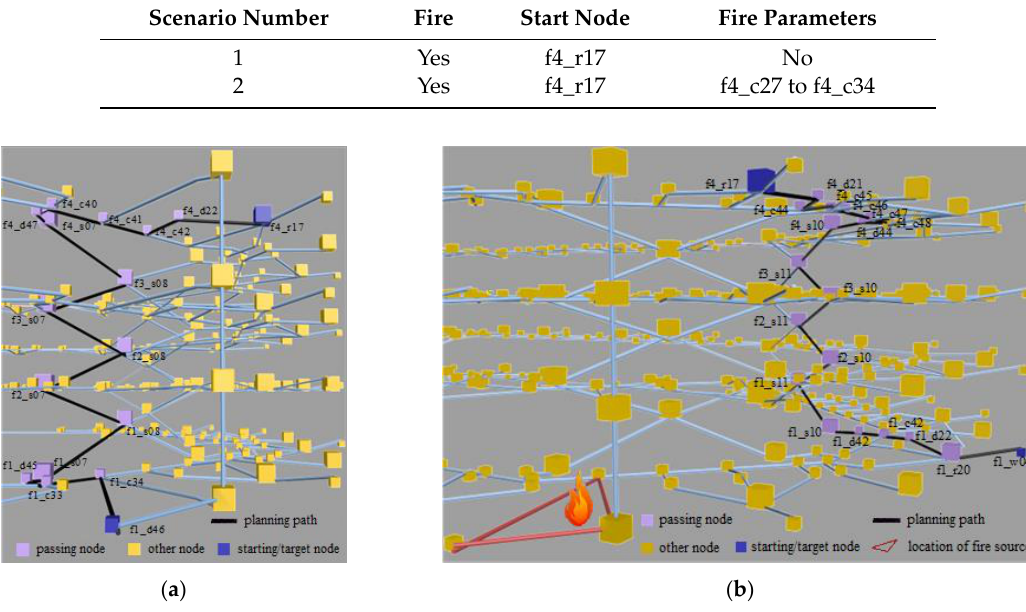
Figure 11. Impact of fire parameters on emergency evacuation routing. ( a ) Planning path in scenario 1; ( b ) Planning path in scenario 2.